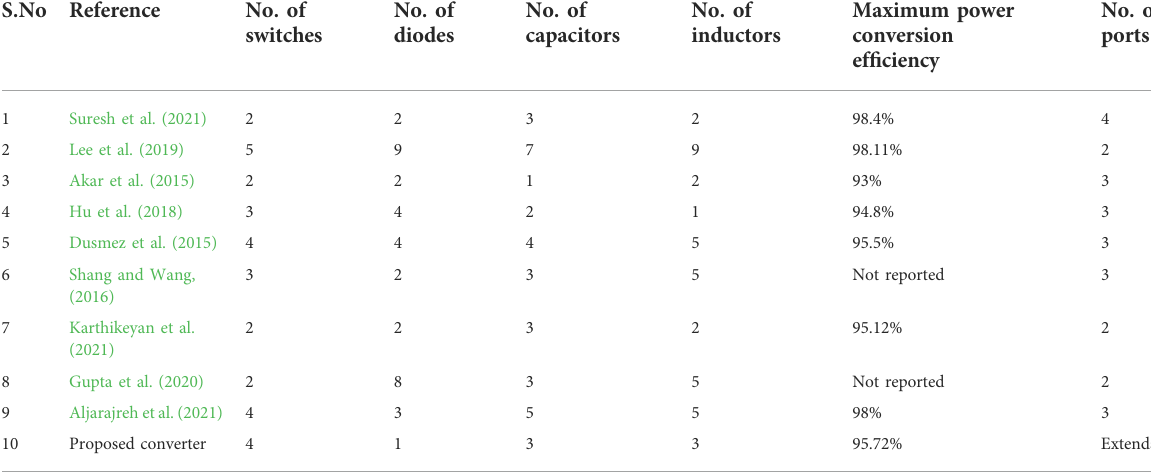
TABLE 2 Performance comparison of various Cuk-derived